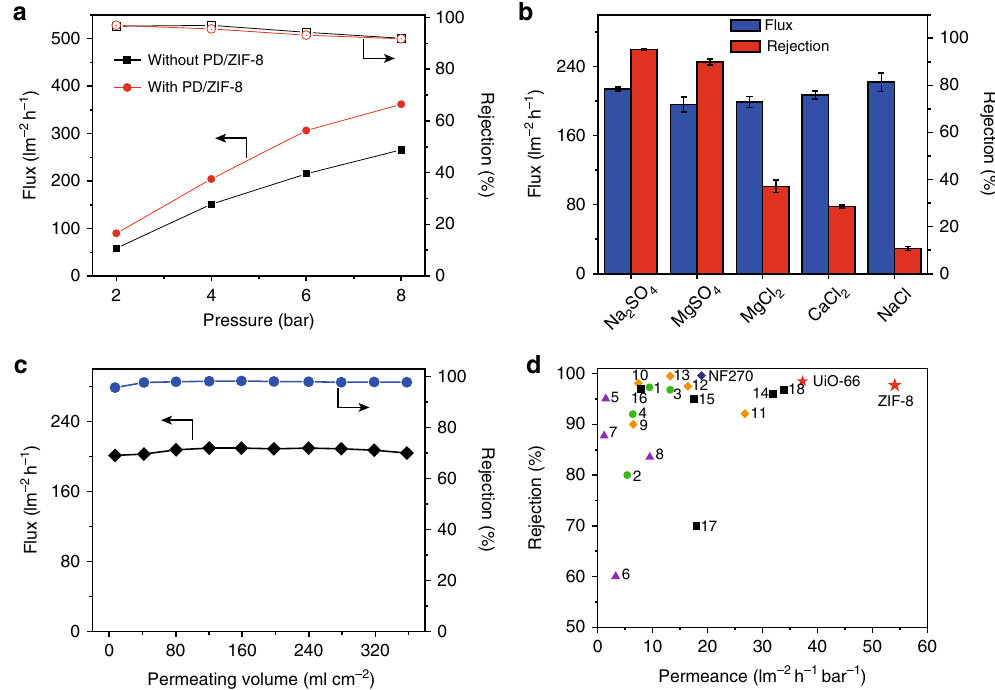
Fig. 4 Desalination performance of PA NF membranes. a Flux and rejection of the PA NF membranes prepared from the SWCNTs/PES composite membrane with and without PD/ZIF-8 nanoparticles loading with respect to applied pressure (Na 2 SO 4 concentration: 1000 ppm). b Variation of fl ux and rejection of PA NF membranes prepared from PD/ZIF-8 nanoparticles loaded SWCNTs/PES composite membrane with respect to different salt solutions (salt concentration: 1000 ppm; applied pressure: 4 bar). c Variation of fl ux and rejection of PA NF membrane prepared from PD/ZIF-8 nanoparticles loaded SWCNTs/PES composite membrane as a function of permeating volume (Na 2 SO 4 concentration: 1000ppm; applied pressure: 4 bar). d Summary of the fi ltration performance of the state-of-the-art NF membranes reported in literature in consideration of permeance and rejection for Na